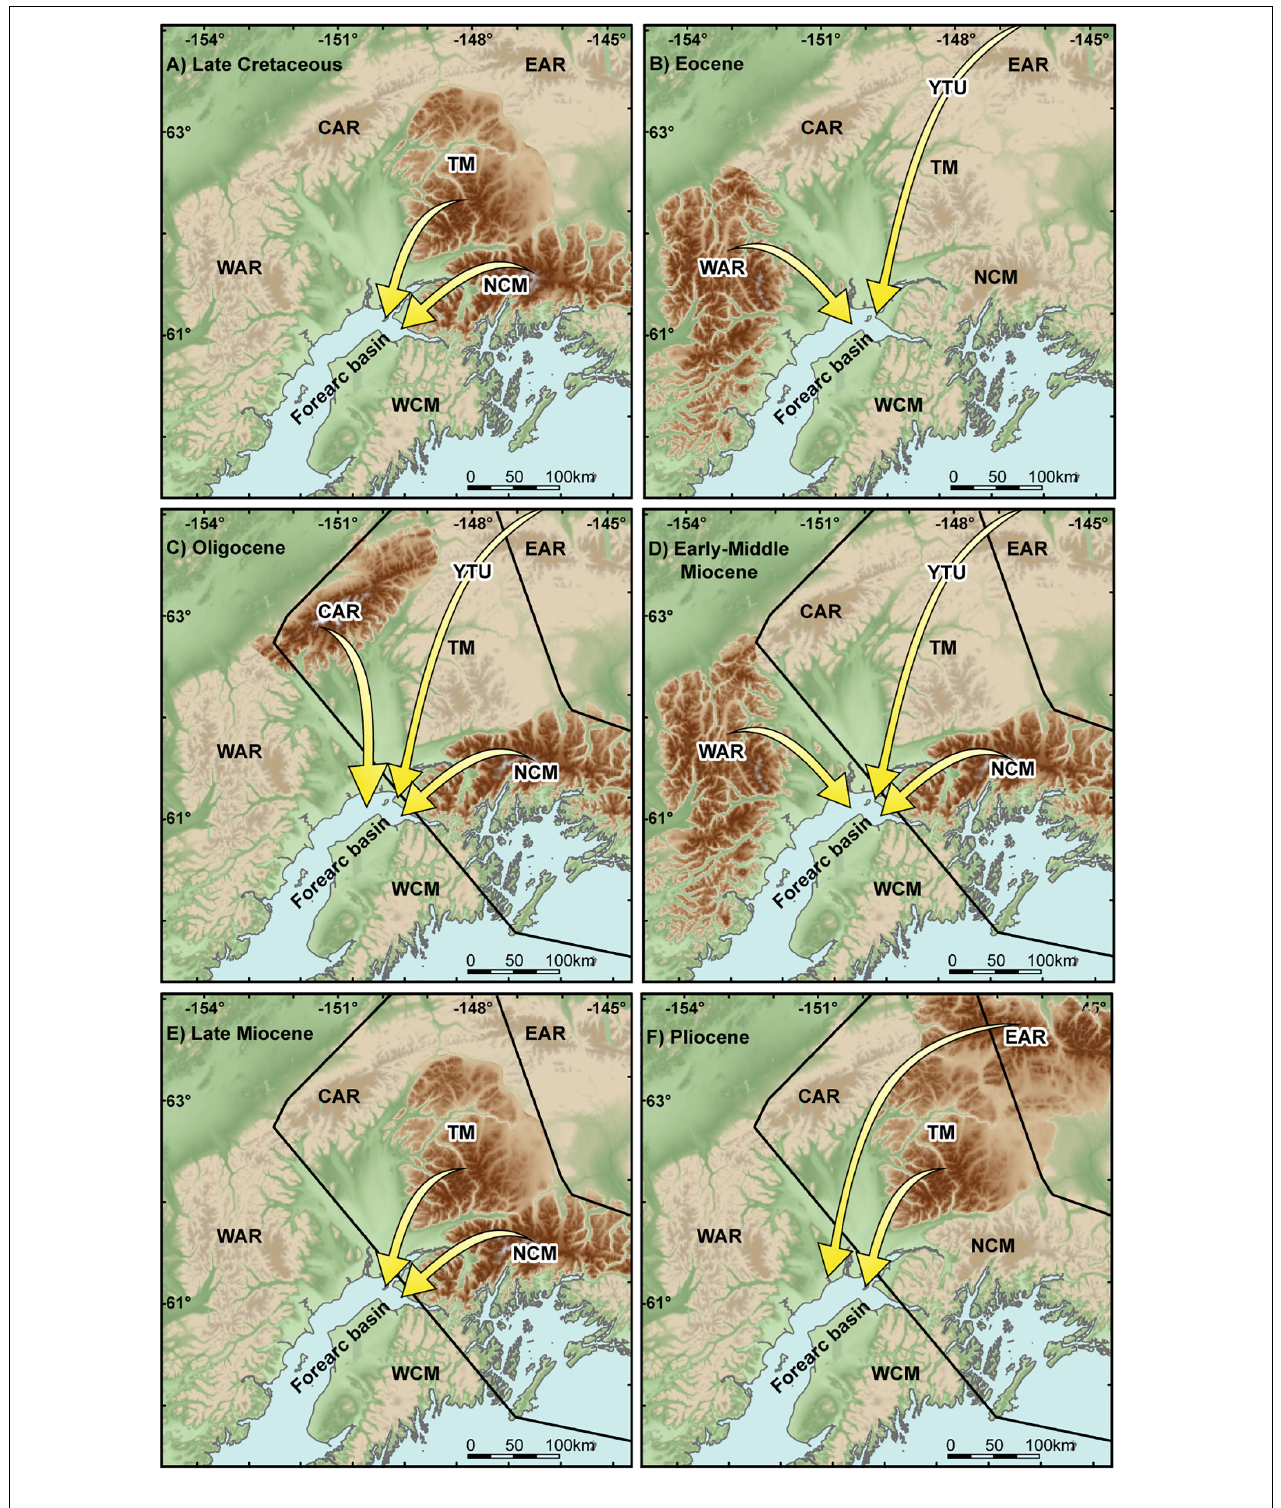
FIGURE 10 | Topographic map of the study area illustrating the predominant sedimentary source regions based on previous interpretations discussed in the text and the modeling results presented here for the (A) Late Cretaceous, (B) Eocene, (C) Oligocene, (D) Early-Middle Miocene, (E) Late Miocene, and (F) Pliocene. The black polygon in (C—F) is the present-day position of the Yakutat microplate. Note that forearc strata are contained within the basin, whereas accretionary prism strata are found in the uplifted Chugach Mountain Range. WAR, western Alaska Range; CAR, central Alaska Range; EAR, eastern Alaska Range; TM, Talkeetna Mountains; NCM, northern Chugach Mountains; WCM, western Chugach Mountains; YTU, Yukon Tanana Uplands.